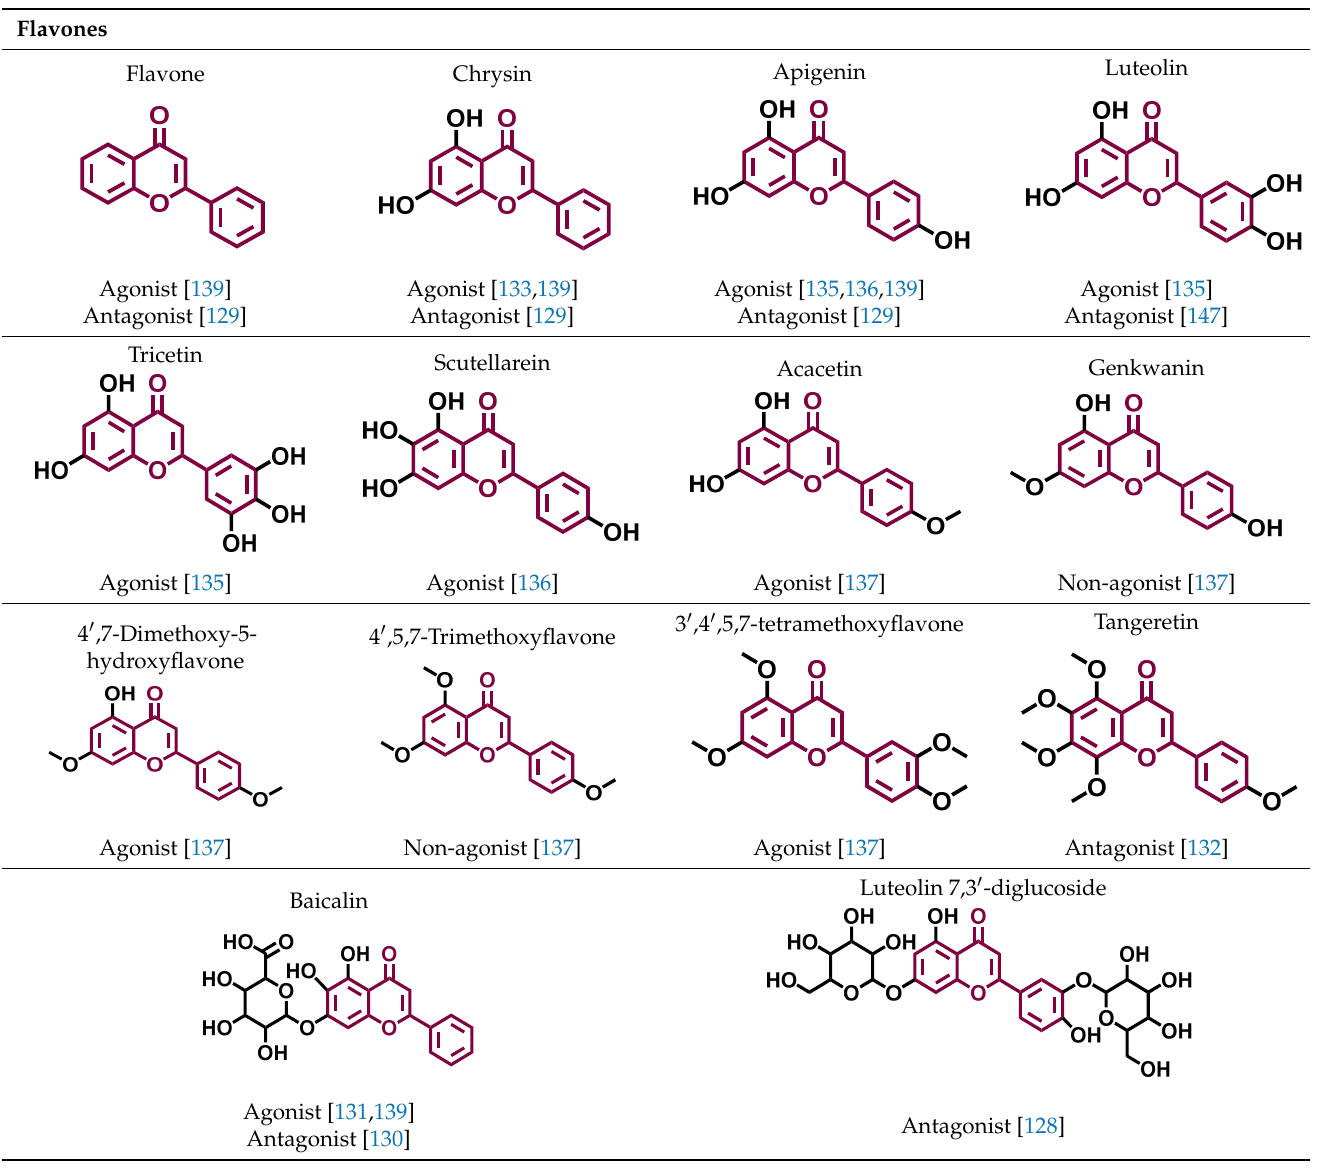
Table 2. Structures and AhR activity reported for the flavone class of compounds.